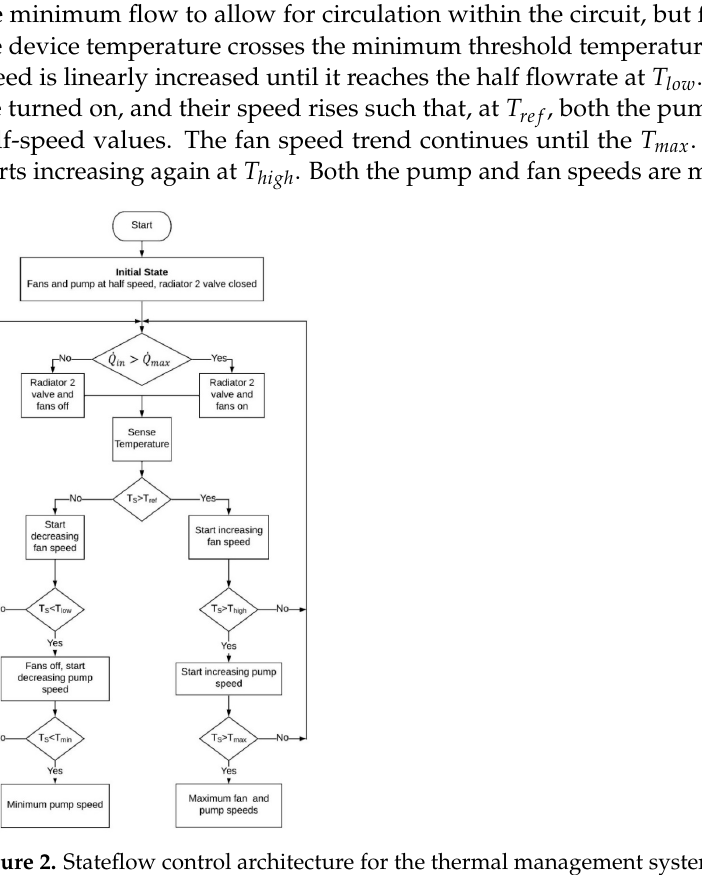
Figure 2. Stateflow control architecture for the thermal management system.